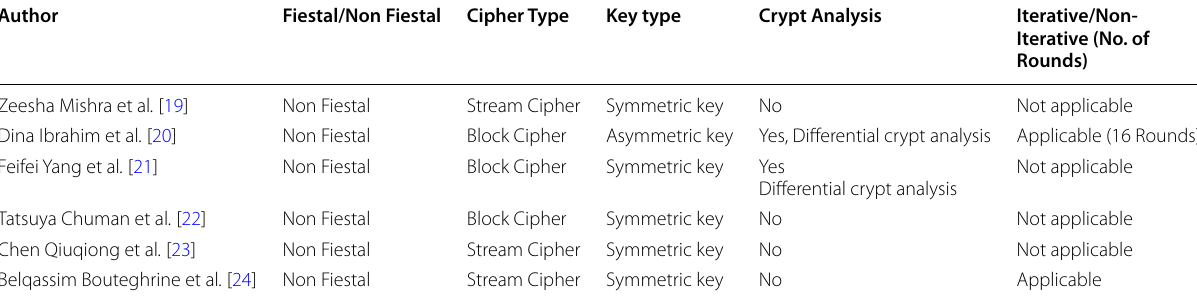
Table 1 Summary of literature